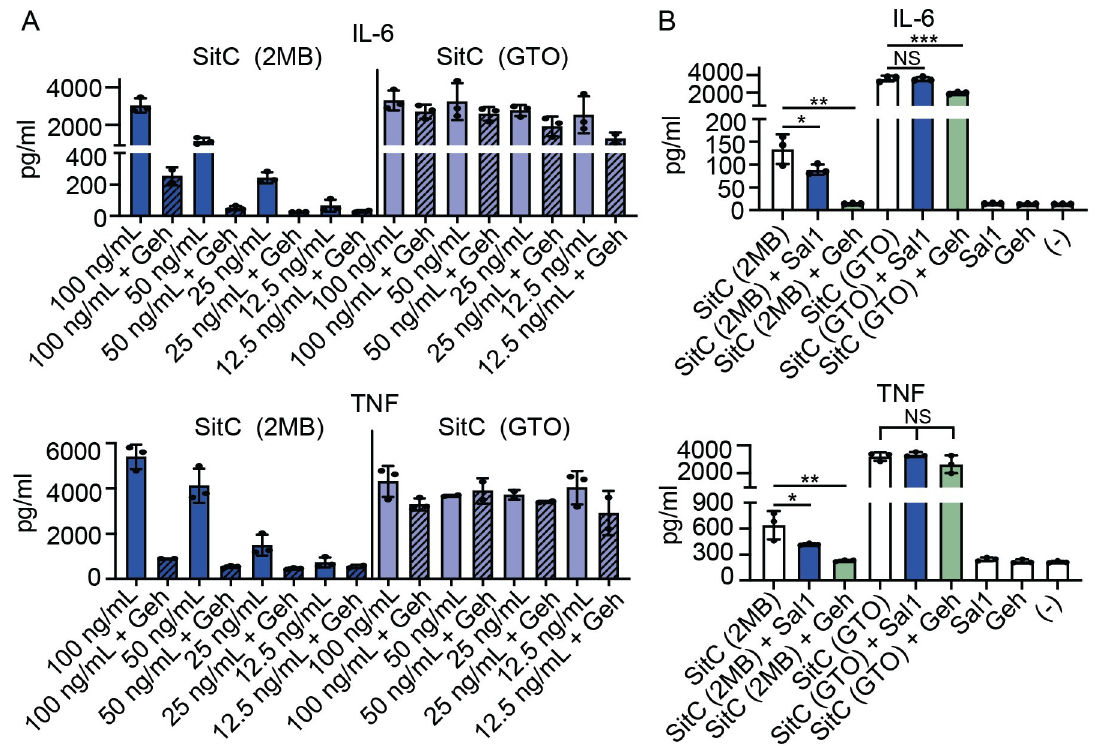
Fig 5. Geh does not inactivate S . aureus lipoproteins with UFA moieties. (A) IL-6 and TNF production by BMM after addition of SitC (varying concentrations (ng/mL)) purified from a Δ bmfBB mutant grown in RPMI supplemented with 2MB (9 mM) or GTO (50 μ M) that was either untreated or treated with Geh (20 μ M SitC: 1 μ M Geh). (B) IL-6 and TNF production by BMM after addition of SitC (100 ng/mL) purified from a Δ bmfBB mutant grown in RPMI supplemented with 2MB (9 mM) or GTO (50 μ M) that was either untreated or treated with Sal1 or Geh (20 μ M SitC: 1 μ M Sal1 or Geh). Data from cytokine assays display mean +/- SD from one of at least three independent experiments conducted in triplicate. Statistical significance for (B) was determined by one-way ANOVA with Tukey’s post hoc test. � P < 0.05; �� P < 0.01; ��� P <